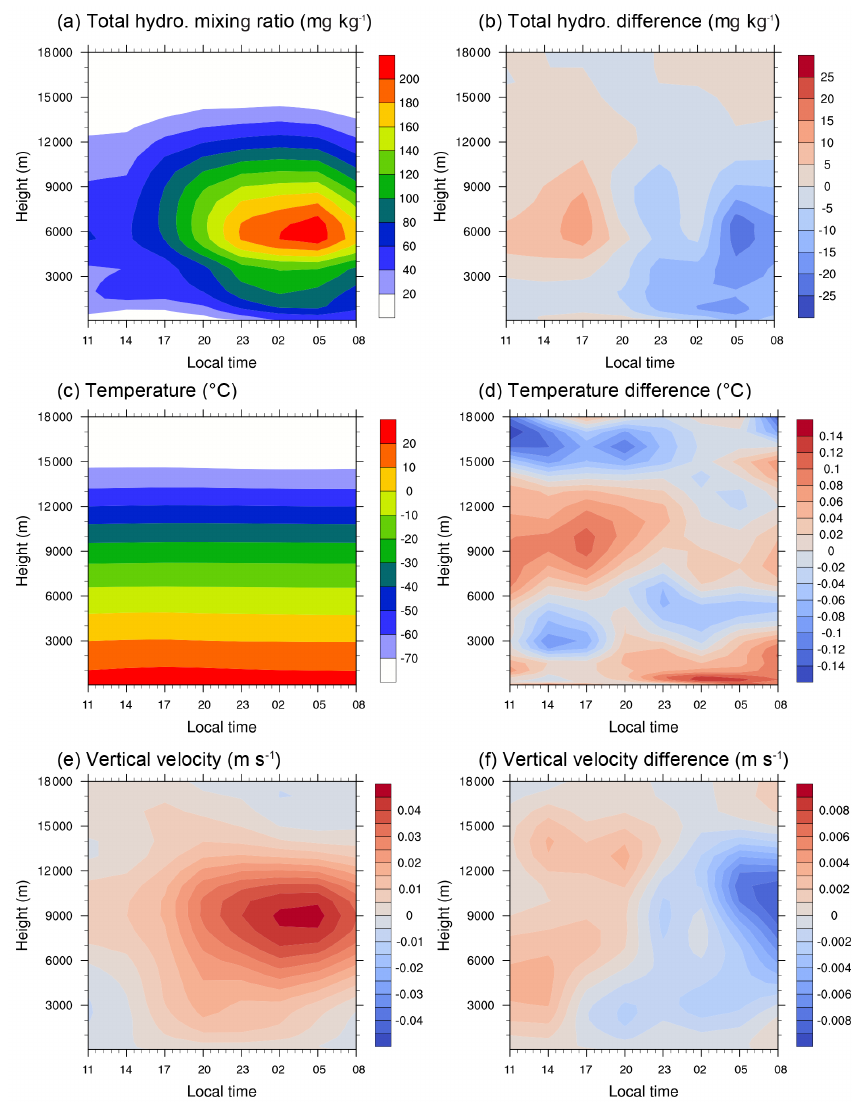
Figure 12. Diurnal evolution of vertical profiles over the Borneo region (r2) in FF for (a) total hydrometeor mixing ratio (mgkg − 1 ), (c) tem- perature ( ◦ C), and (e) vertical velocity (ms − 1 ). Data are averaged all the nocturnal convections. Panels (b) , (d) , and (f) are the differences between FF and FFBB (FFBB − FF) for each